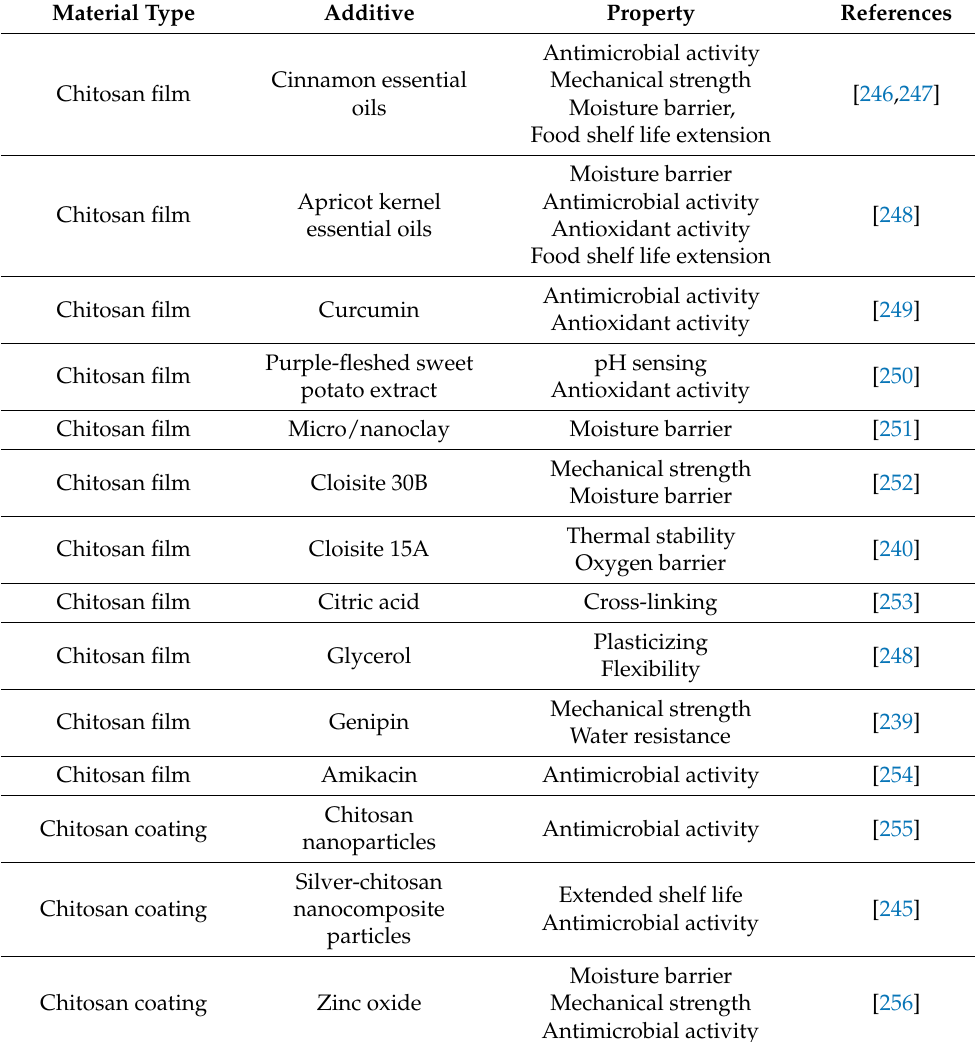
Table 4. The versatile films or coatings based on various formulas and